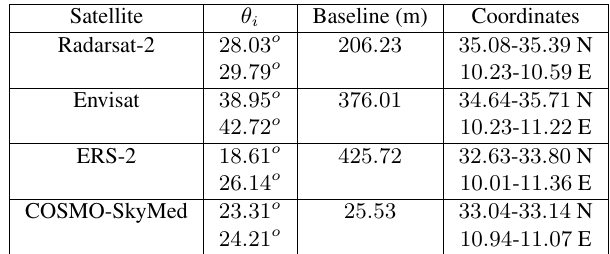
Table 1: Overview of the four satellites which their SLC data are used in this paper.